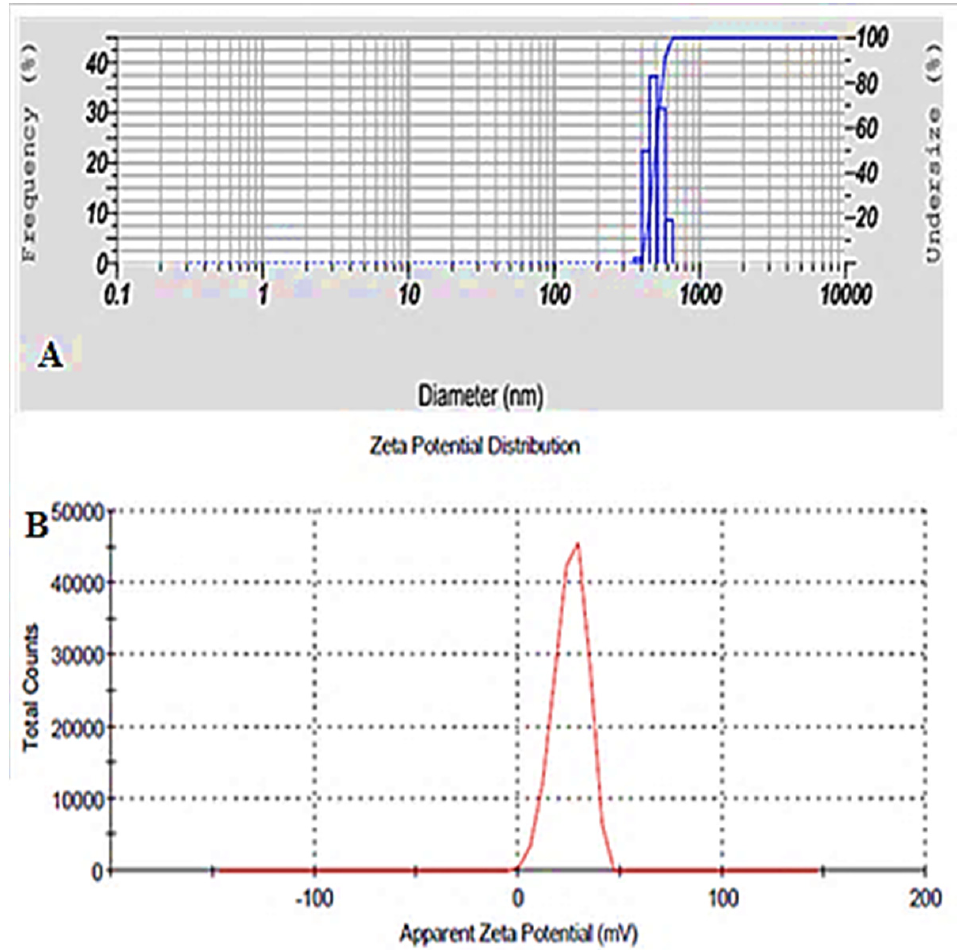
Figure 4. ( A ) Vesicle size and ( B ) Zeta potential graph of EZL ‐ PNsopt.